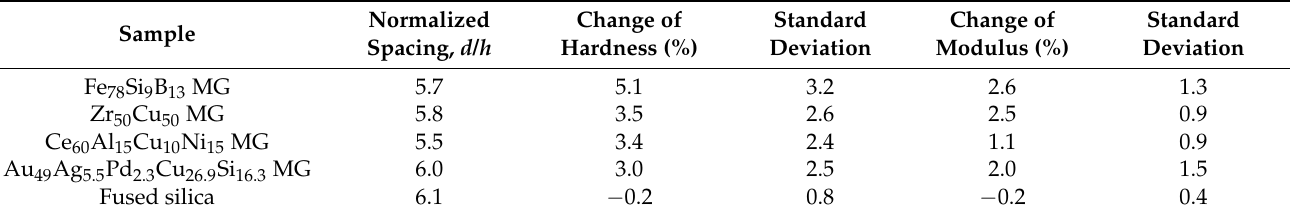
Figure 2. Nanoindentation tests. ( a ) Representative load–depth curves of nanoindentation tests on the Fe 78 Si 9 B 13 , Zr 50 Cu 50 , Au 49 Ag 5.5 Pd 2.3 Cu 26.9 Si 16.3 , and Ce 60 Al 15 Cu 10 Ni 15 metallic glass samples; fused silica; and polycrystal nickel. The maximum load was 50 mN, and the loading rate was 1 mN/s. The curves are offset horizontally for clarity. ( b ) The normalized mean hardness ( H / H 0 ) and ( c ) normalized mean modulus ( E / E 0 ) of the Fe 78 Si 9 B 13 metallic glass as a function of the normalized spacing ( d / h ) obtained using a 6 × 6 array nanoindentation mapping. H 0 and E 0 are the “normal” values obtained with a large normalized spacing ( d / h ≈ 25). Table 2. The critical normalized spacing and corresponding changes of the hardness and elastic modulus of the four tested metallic glasses and fused silica relative to the “normal” values obtained with a large normalized spacing ( d / h ≈